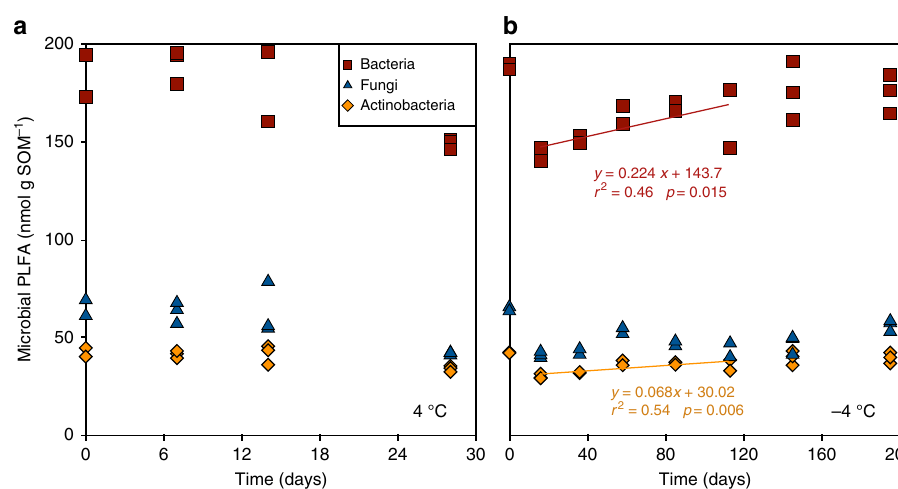
Fig. 2 Concentration of bacterial and actinobacterial phospholipid fatty acid (PLFA) markers increased signi fi cantly over time in the frozen samples. Changes with time in bacterial (red squares), fungal (blue triangles) and actinobacterial (orange diamonds) PFLA concentrations in soils incubated at 4 °C (panel a ) and − 4 °C (panel b ). Linear regressions in panel b represents signi fi cant increases in concentrations of bacterial and actinobacterial PLFA markers until day 113, during which CO 2 production occurred in the samples (cf. Fig.